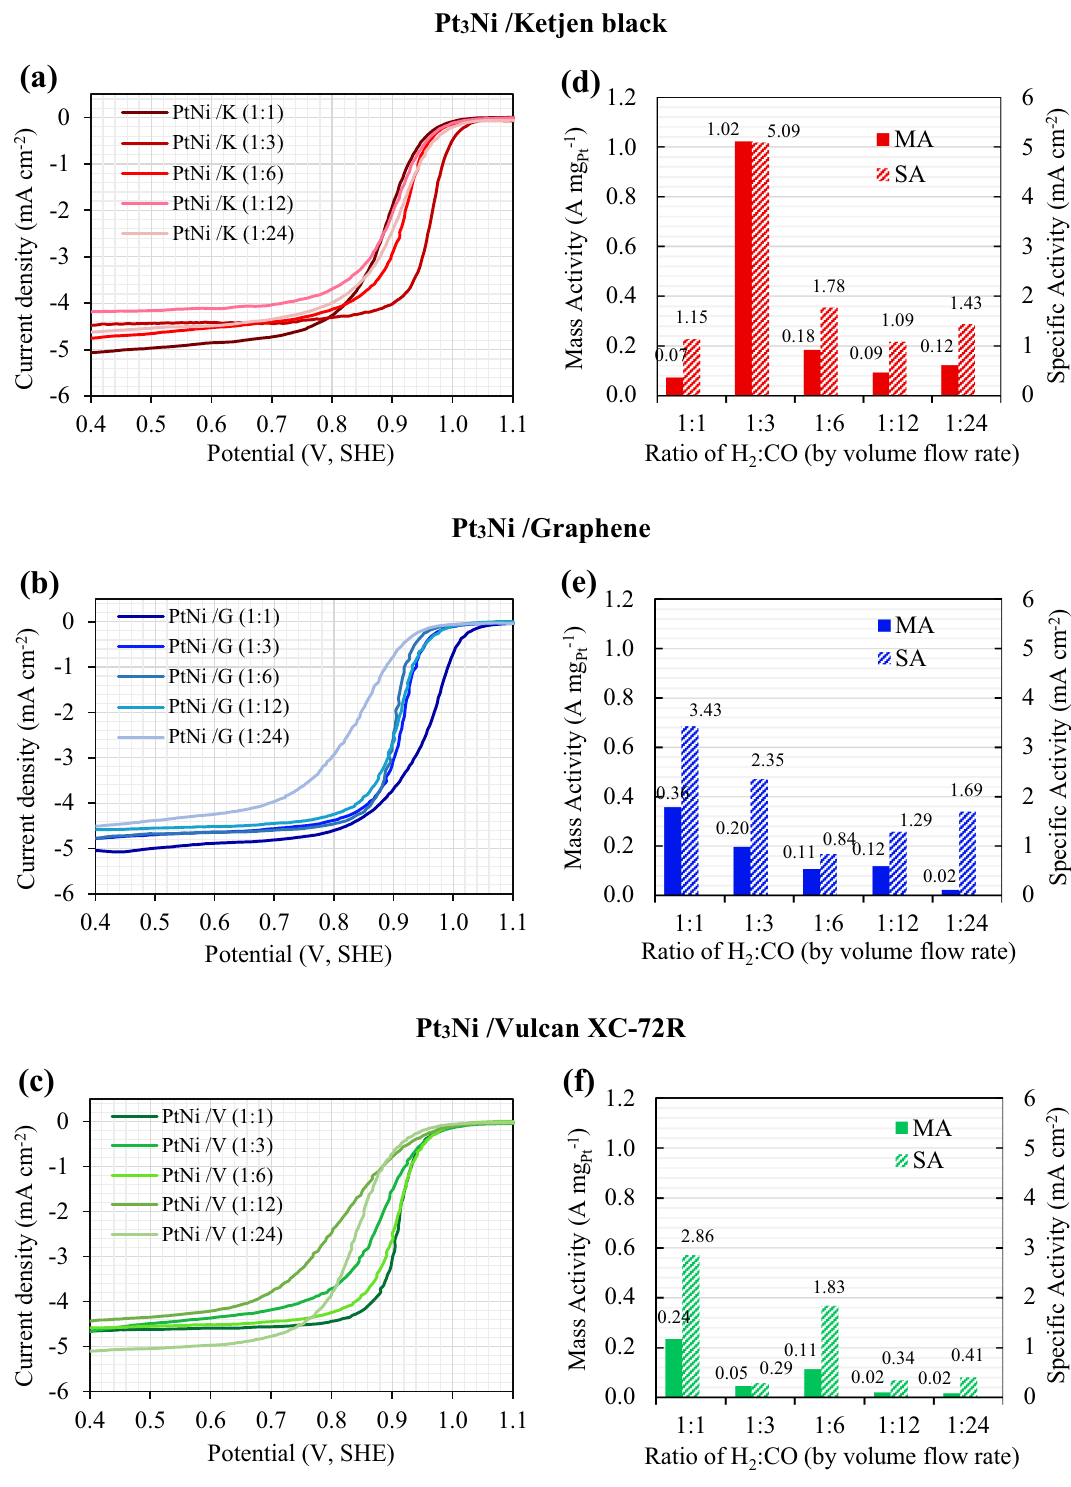
Figure 3. The linear sweep voltammograms (LSV) of Pt 3 Ni on Ketjen black, Graphene and Vulcan XC-72R supports with varying H 2 :CO ratios is shown in ( a ), ( b ), and ( c ); where ( d ), ( e ), and ( f ) show the ORR activities of mass activity (MA) and specific activity